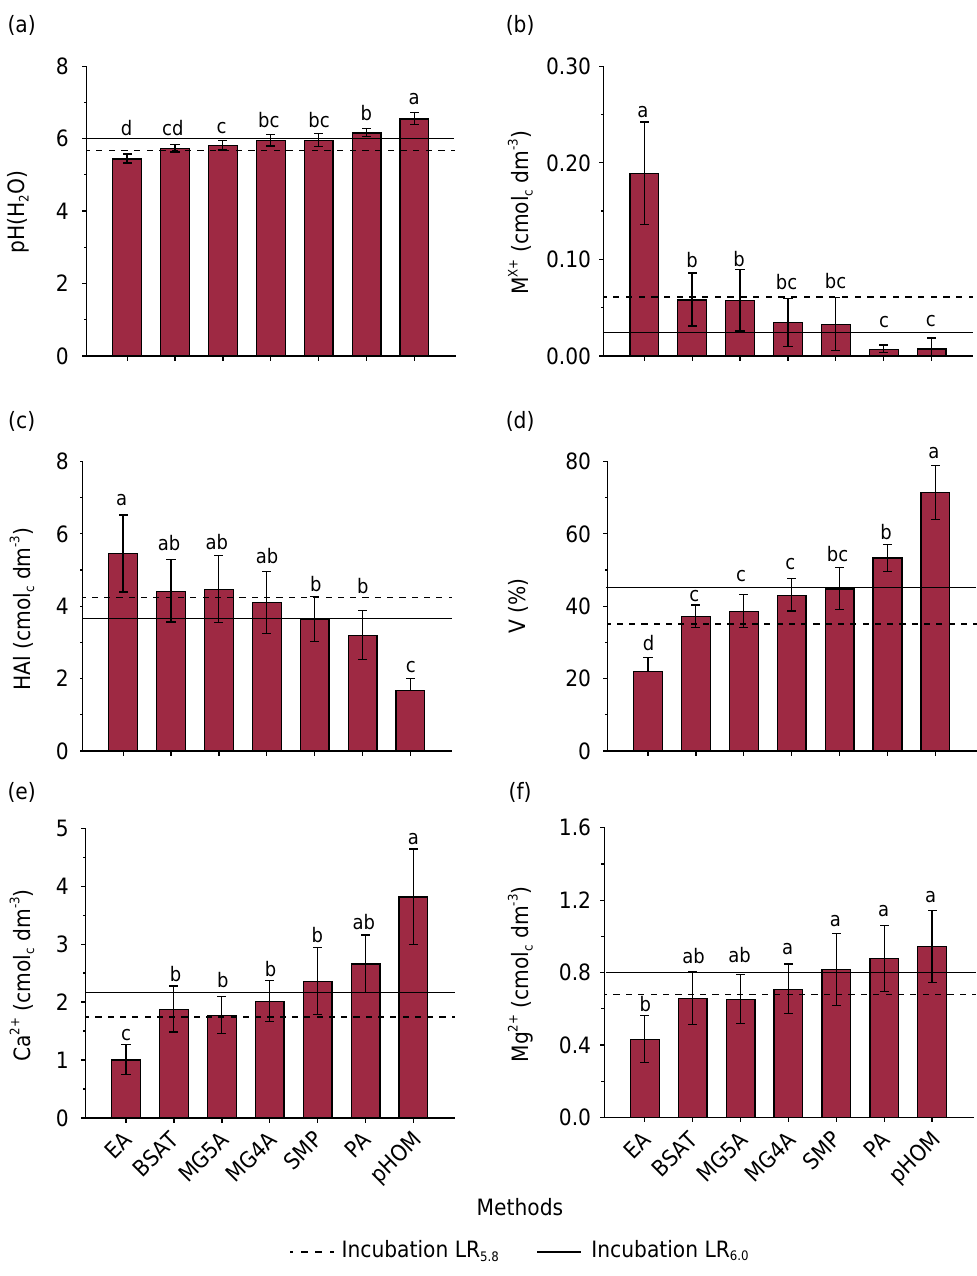
Figure 3. Soil pH (a); exchangeable acidity (b); potential acidity (c); base saturation percentage (d), exchangeable calcium (e), and exchangeable magnesium (f) determined from the exchangeable acidity (EA), base saturation (BSAT), 5th (MG5A) and 4th (MG4A) Approximation to the Minas Gerais State, Shoemaker-McLean-Pratt buffer (SMP), potential acidity (PA), and soil pH-organic matter (pHOM) methods. Data plotted as means of the 22 soils used in the incubation study. Dashed and solid lines indicate the respective property associated with LR determined from incubation to raise soil pH to 5.8 and 6.0, respectively. Means followed by the same letter are not significantly different (p<0.05, Tukey test). Error bars represent 95 % confidence